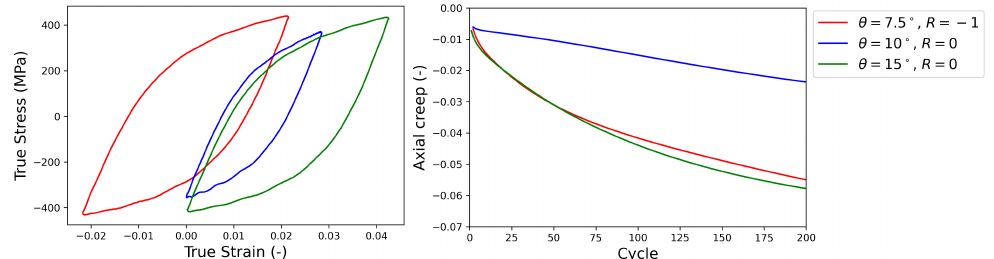
Figure 4. ( left ) Experimental stress–strain hysteresis loops recorded for uniaxial fatigue after the saturation of the mean stress and ( right ) axial creep for the HPTF loading cases given in the legend, where θ is the amplitude of the cyclic torsion loading, and R is the ratio of the minimum vs. maximum torsion